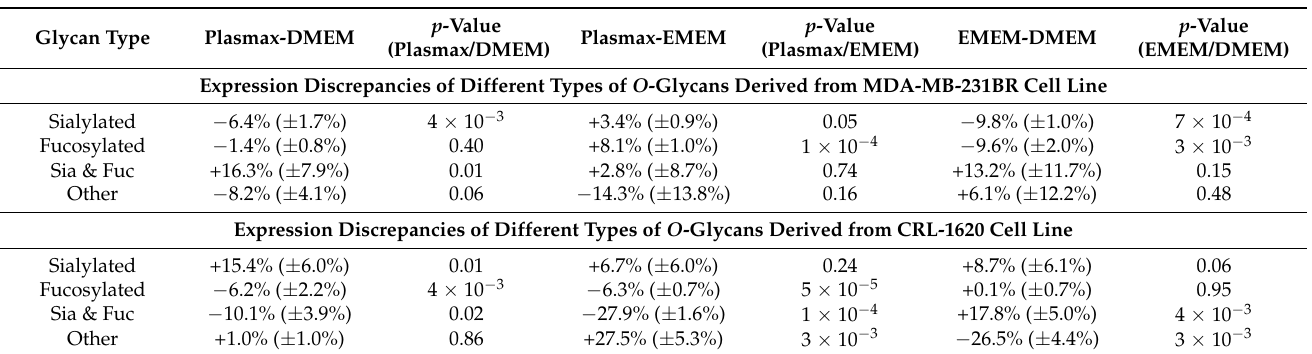
Table 2. Expression discrepancies of different types of O -glycans derived from the 231BR and CRL cell lines in three media. The numbers in brackets are standard deviations ( n = 3). p -values were calculated using Student’s t -tests to indicate the significant level of